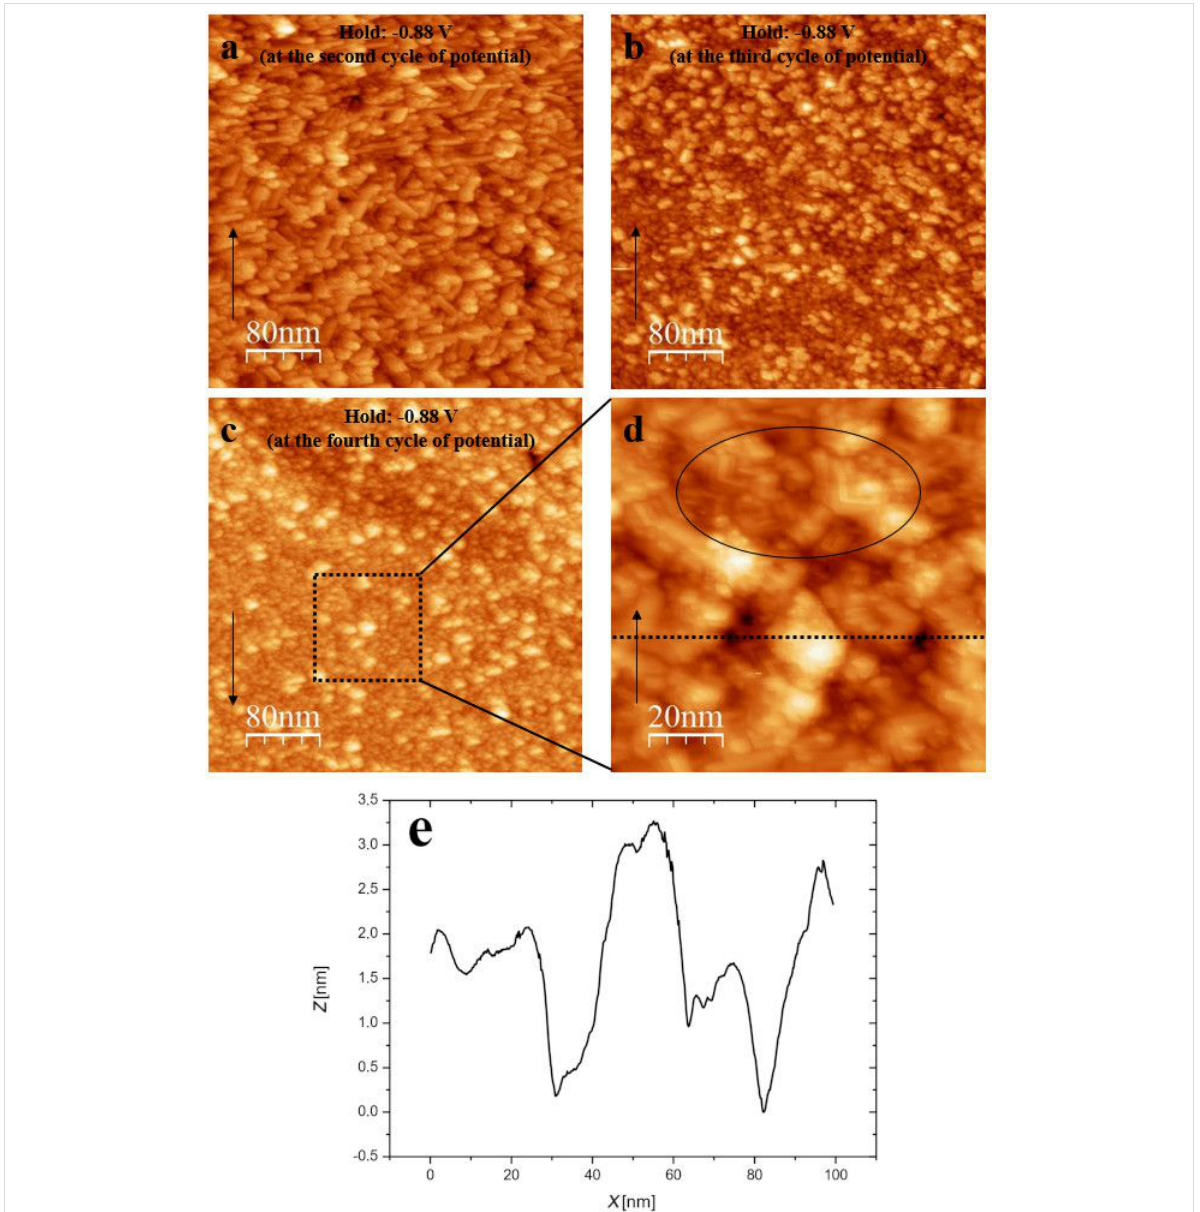
Figure 9: STM images of Sb overpotential deposition on Au(111) in 0.25 mM Sb 2 O 3 /0.5 M H 2 SO 4 electrolyte. (a) The potential was held at − 0.88 V at the second potential cycle. (b) The potential was held at − 0.88 V at the third potential cycle. (c) The potential was held at − 0.88 V at the fourth poten- tial cycle. (d) The zoomed in details of image c (black box) and (e) the cross section of image c (black dotted line). Sample bias = 50 mV, set point = 0.5 nA and scan rate = 3.04 ln/s. Integral gain: 6 and proportional gain: 8. The arrows indicate the scan direction. Line-by-line correction is used for the